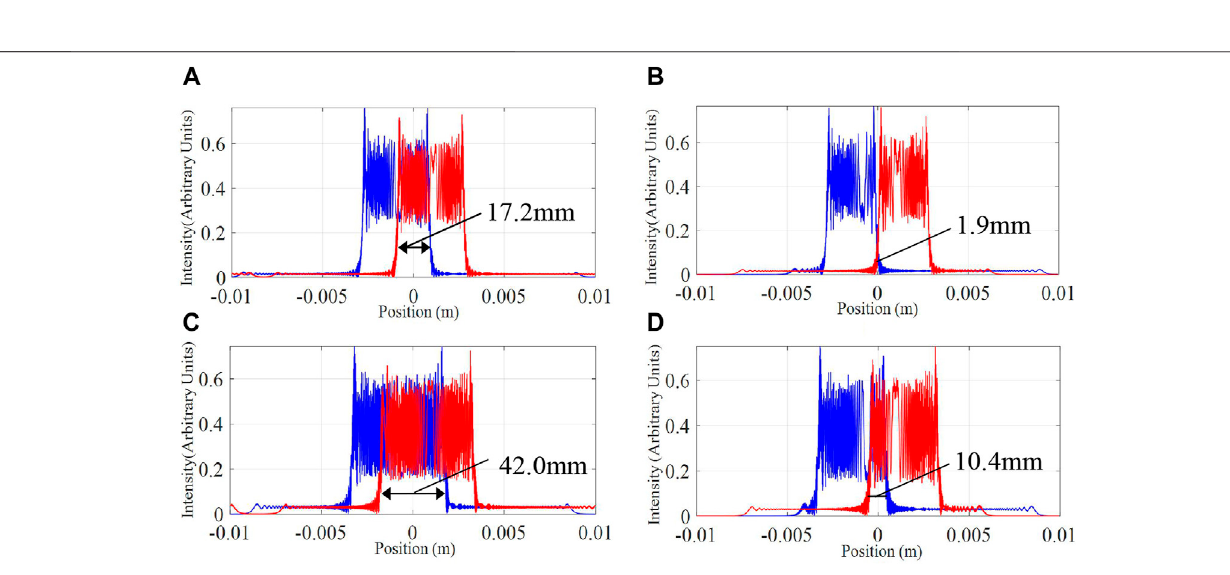
Frontiers in Materials |